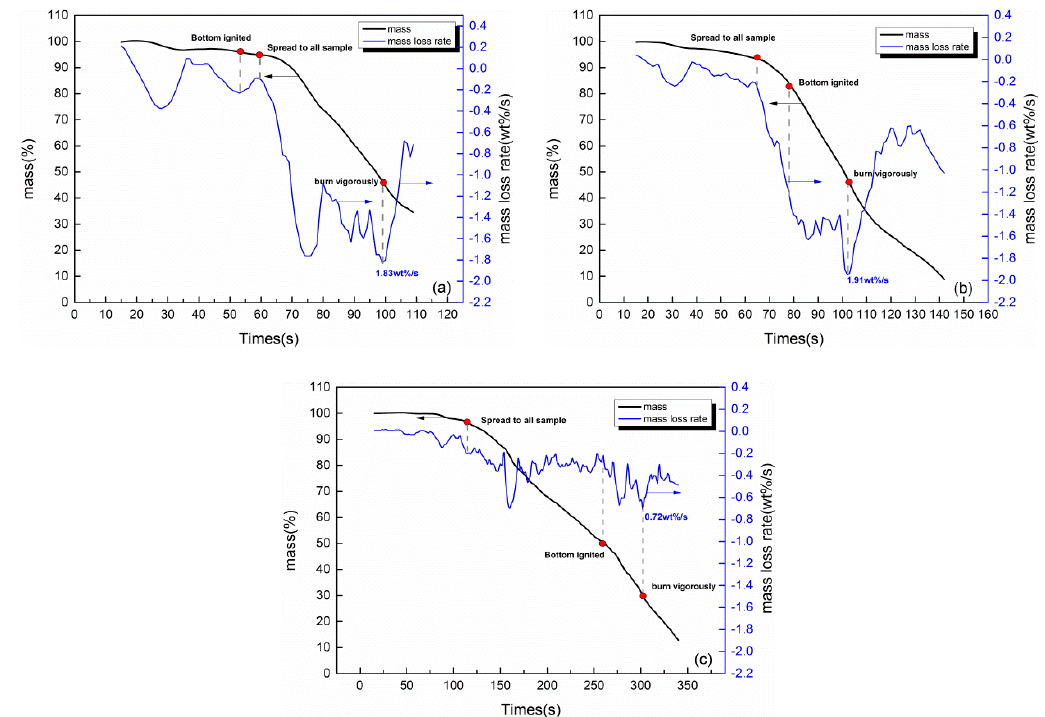
Figure 7. Mass loss rate of different thickness samples for: ( a ) 1 cm; ( b ) 2 cm; and ( c ) 5 cm.